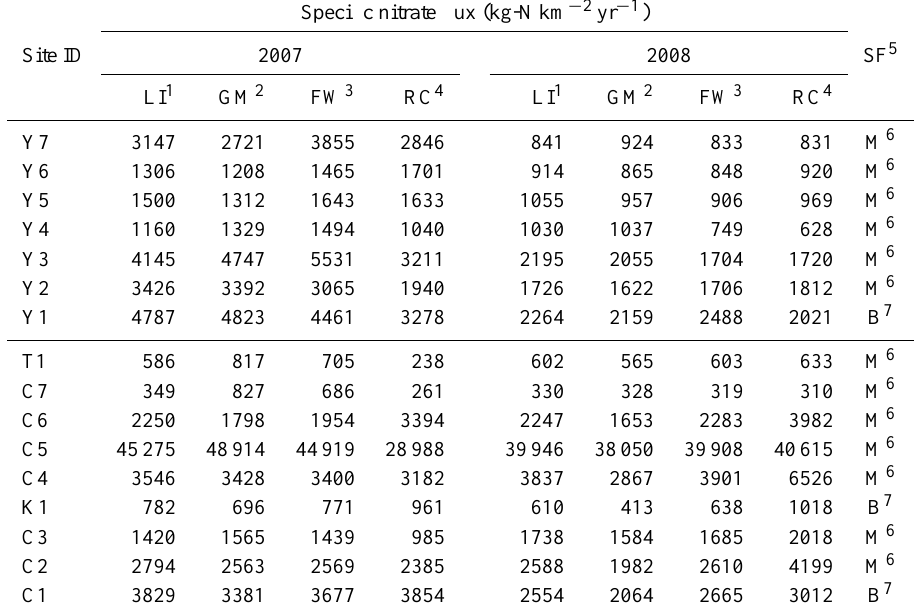
Table 5. NO 3 -N flux derived from the 4 flux calculation methods for the 16 sites.